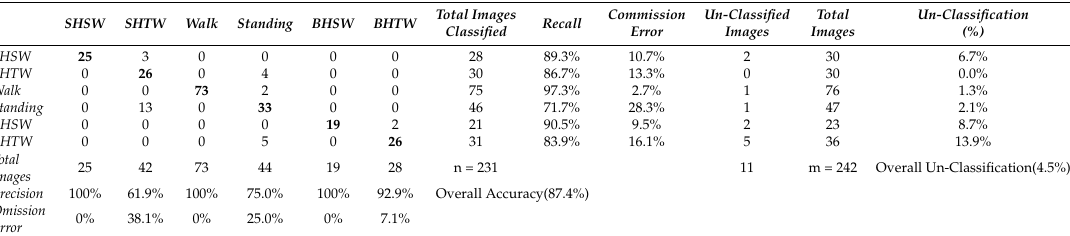
Table 9. Classification matrix for Moshe images.